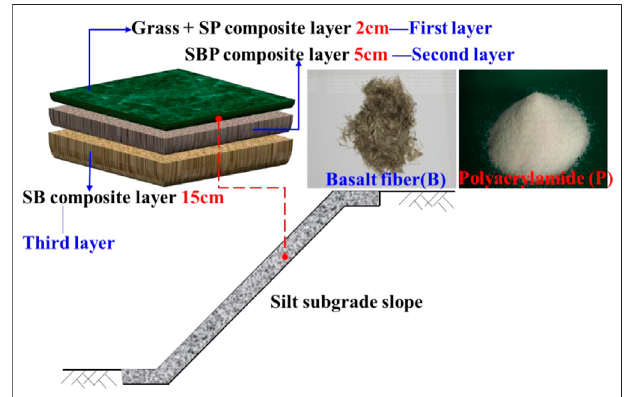
FIGURE 1 | Material and structure of the composite layers for silt subgrade